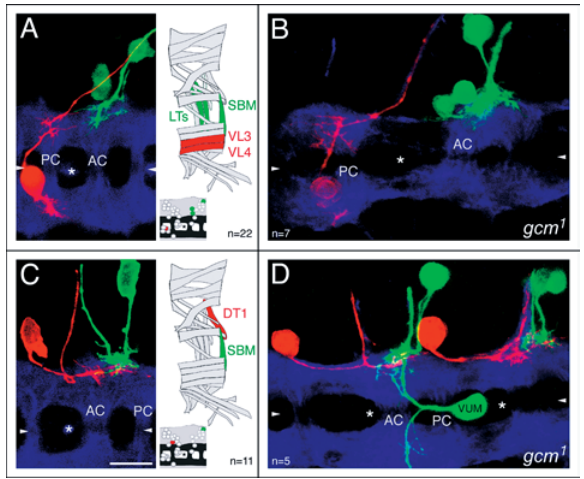
Figure 7. Glial Cell Differentiation Is Not Required for Neuropile Subdivision ISN (red) and SN (green) motor neurons labelled in 15-h-old wild- type (A and C) and gcm mutant (B and D) embryos. The neuropile, visualised with anti-HRP, is shown in blue. (A and B) Motor neurons innervating ventral (VL3–VL4, RP3) internal (red) and external (green) muscles of a segment elaborate their dendrites in separate regions of the neuropile on either side of the segment border (asterisks). This is accentuated when neuromeres separate in gcm mutant embryos (B). (C and D) The DT1 motor neuron (red) is the only ISN motor neuron whose dendrites branch in the SN dendritic domain (green). This dendritic projection pattern is maintained in gcm mutant embryos (D). An SN VUM efferent neuron has also been labelled. Anterior is left and dorsal is up. Symbols and abbreviations: triangles, ventral midline; AC, anterior commissure; PC, posterior commissure; asterisks, dorsoventral channels (landmarks for the segment borders). Scale bar (not applicable to diagrams of CNS and